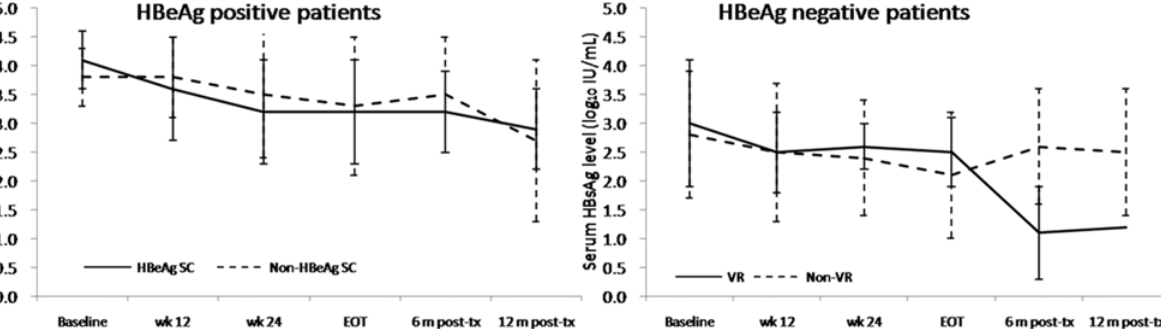
Fig 3. HBsAgkineticsduring and after Peg-IFN therapy according to the treatment response. There was no difference between the HBeAg-positive patients with and without HBeAgseroconversion in the HBsAg decline. The HBeAg-negative patients who achieved HBV DNA < 2000 IU/mL at 12 months post-treatment showed continued HBsAg decline after stopping Peg-IFN. A rebound in the HBsAg level after stopping Peg-IFN was found in the HBeAg- negative patients who did not achieve HBV DNA < 2000 IU/mL at 12 months post-treatment. (VR indicates HBV DNA < 2000 IU/mL 12 months post-